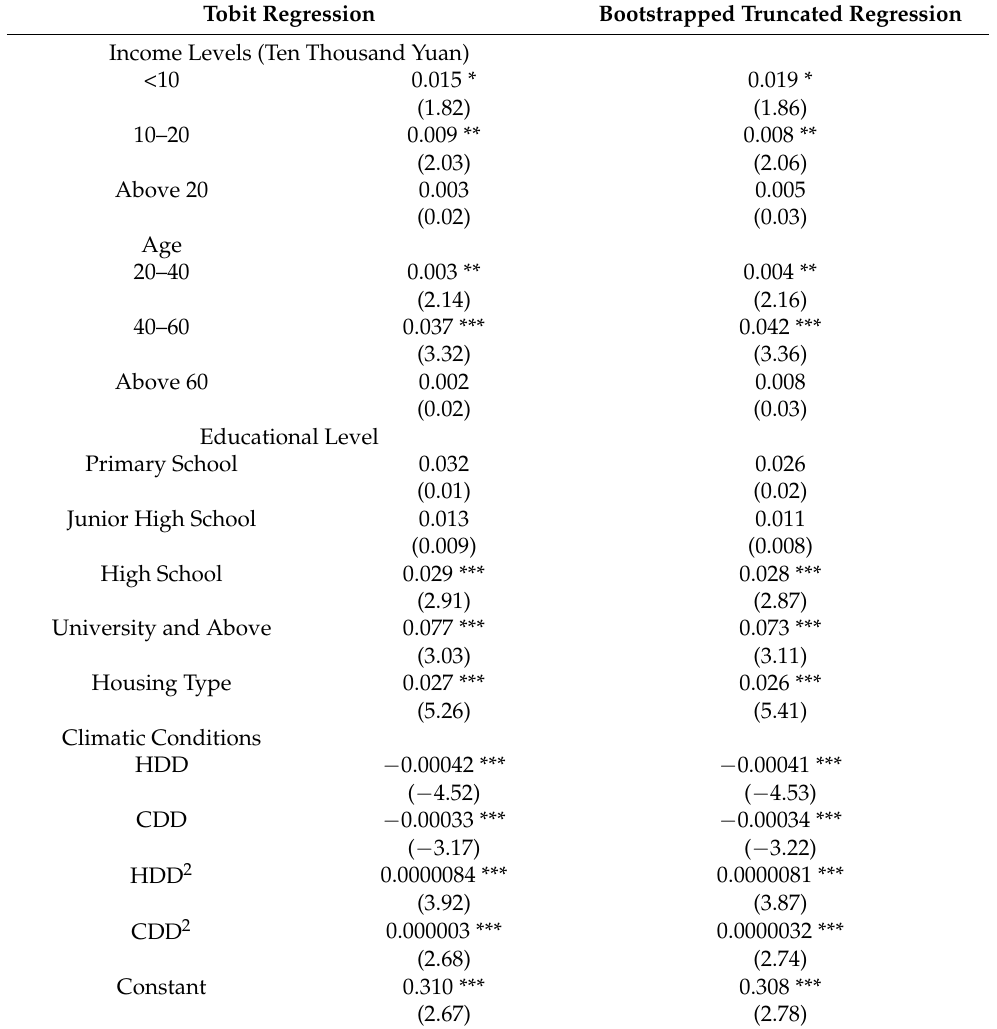
Table 2. Regression